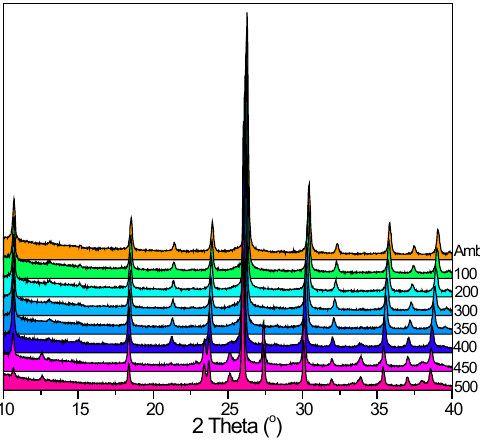
Figure 4. In situ XRD from 400 °C to 500 °C for fresh APMV (precursor), ( left ) full range; ( right ) diffractions from molybdenum oxides (*: Mo 4 O 11 , ◊ : MoO 3 ).